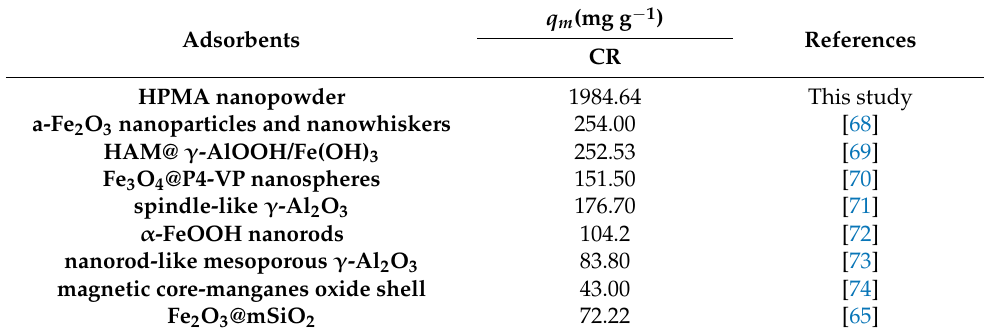
Table 13. Comparison of the maximum monolayer adsorption ( q m ) of different adsorbents for the removal of